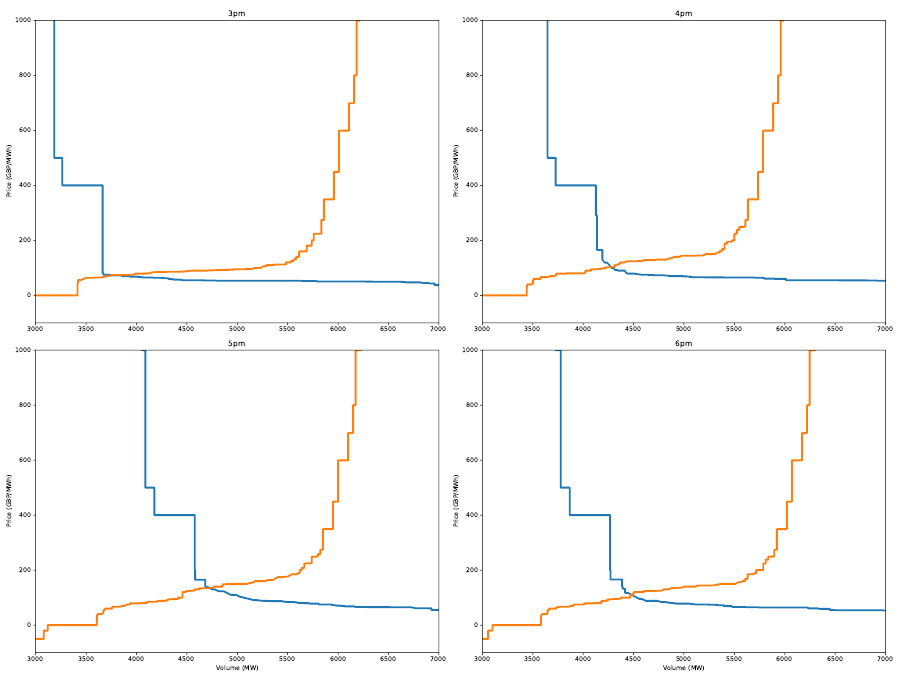
Figure 27. Supply and demand curves for the hours around the peak price on 3 January 2019. The demand curves are in blue and the supply curves are in